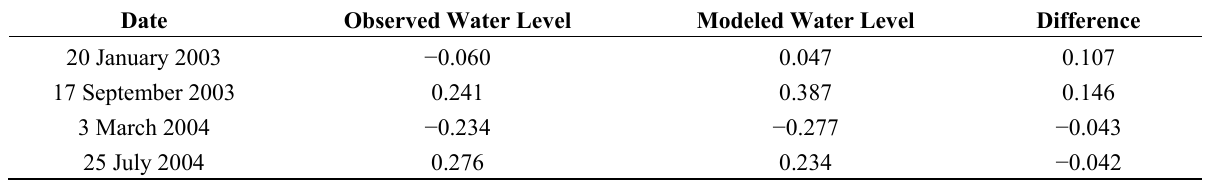
Table 6. Water levels (m-NAVD88) at the Apalachicola